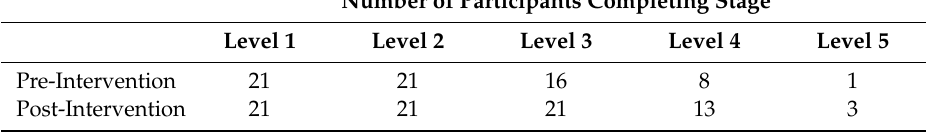
Table 3. The number of participants who completed each level of Chester step test, pre- and post- dancing intervention (total n =